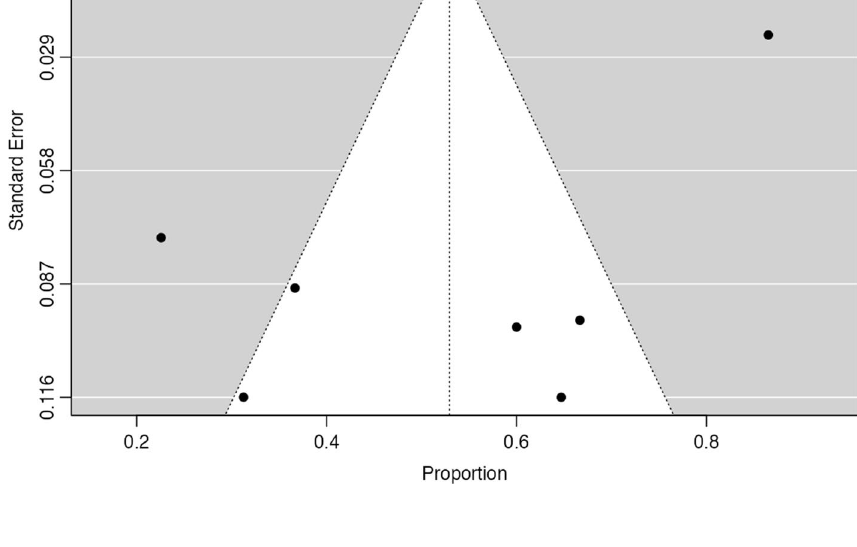
Fig. 8 Forest-plot describing the association between EVB and GCLS. Logarithm for OR is represented in the